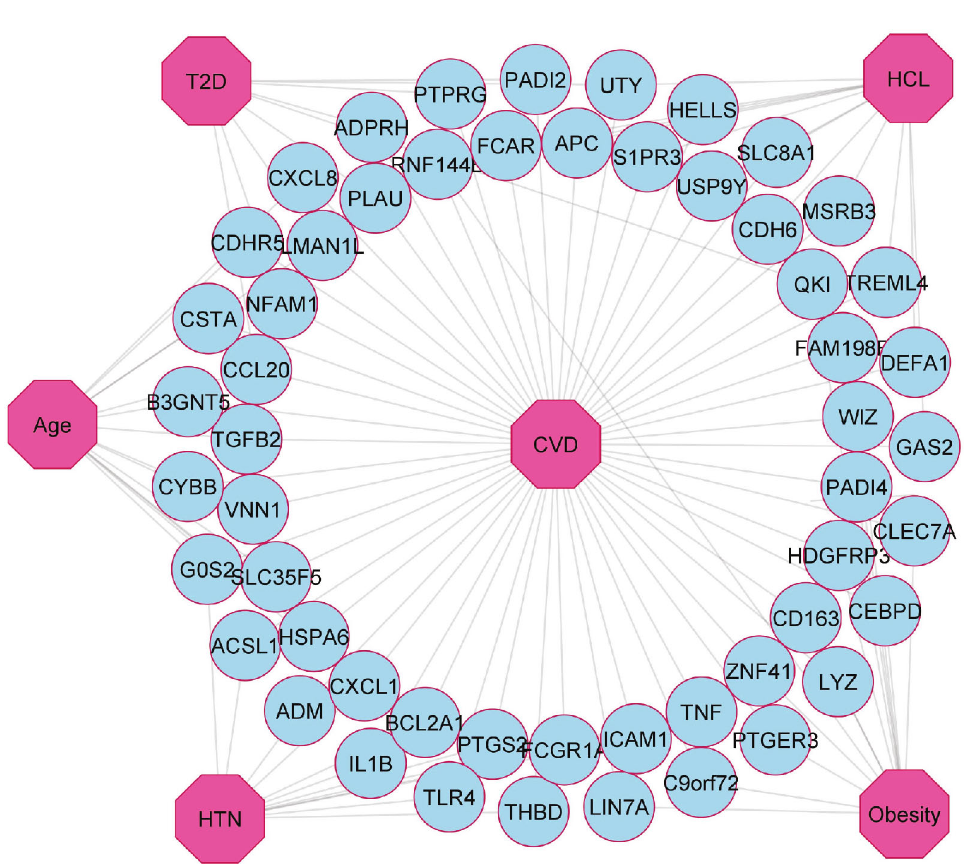
Figure 2: Diseasome network of the upregulated genes that are common between CVD and HTN, T2D, HCL, obesity, and aging. Circular sky blue-colored nodes represent shared upregulated genes, and octagon-shaped nodes represent CVD and its risk